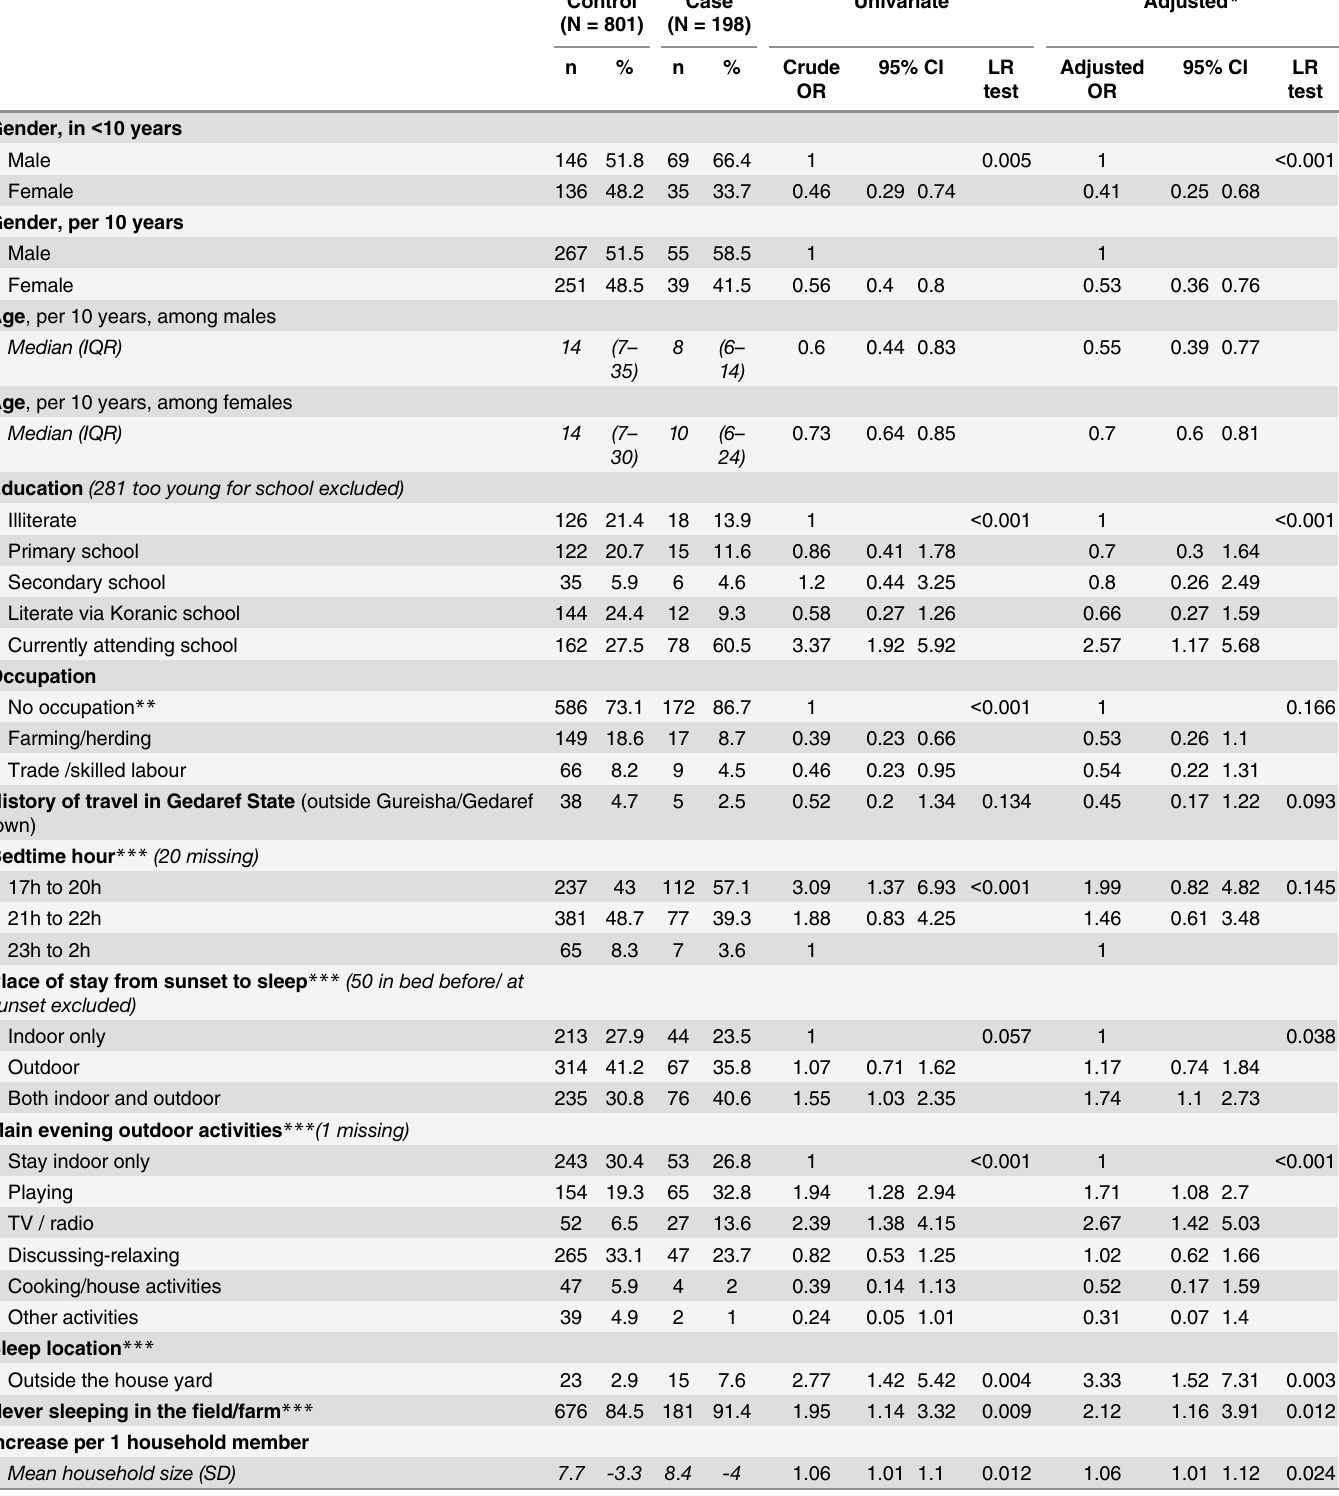
Table 2. Individual level determinants associated (p < 0.20) with VL after adjustment: crude and adjusted analysis. Gedaref State, Sudan, 2012 –